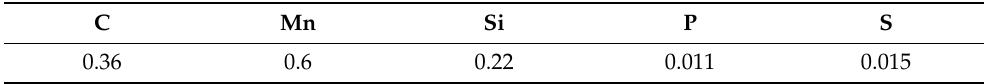
Table 1. Chemical composition of the steels in weight percent.